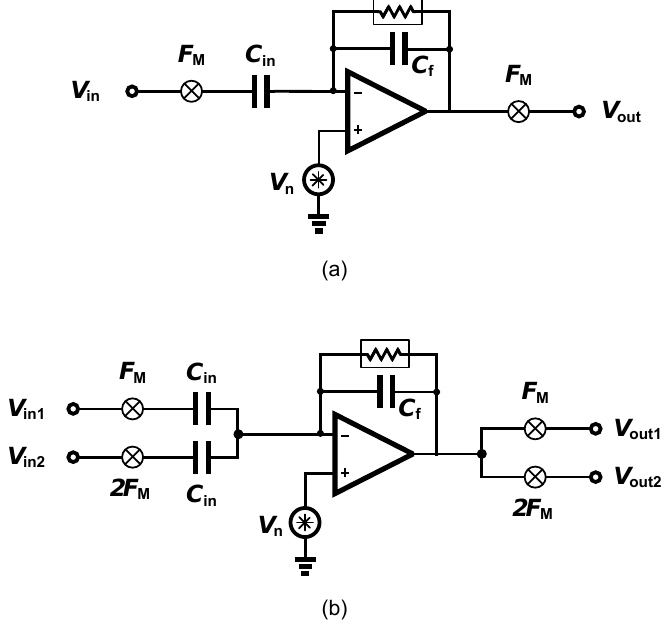
Figure 21. Noise analysis model of ( a ) a single-channel chopper amplifier and ( b ) a two-channel chopper